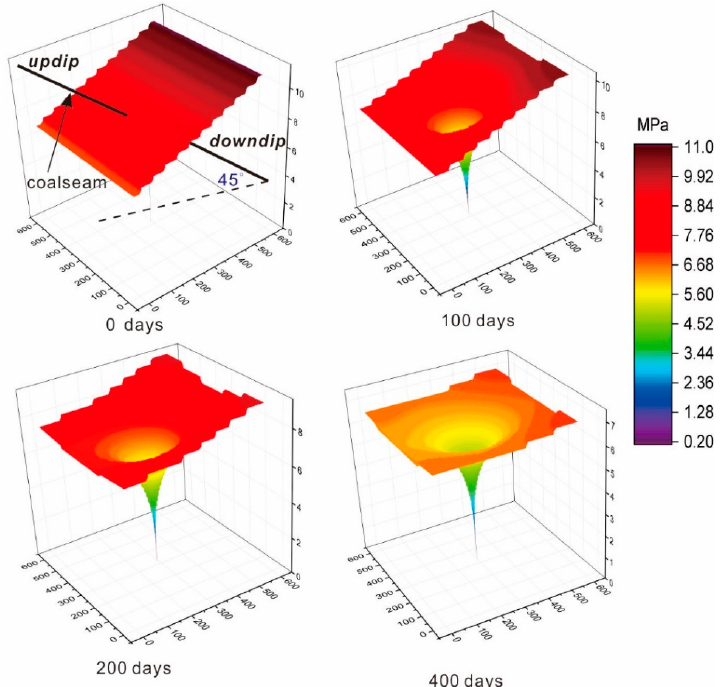
Figure 8. Evolution of the reservoir depressurization funnel during CBM extraction.